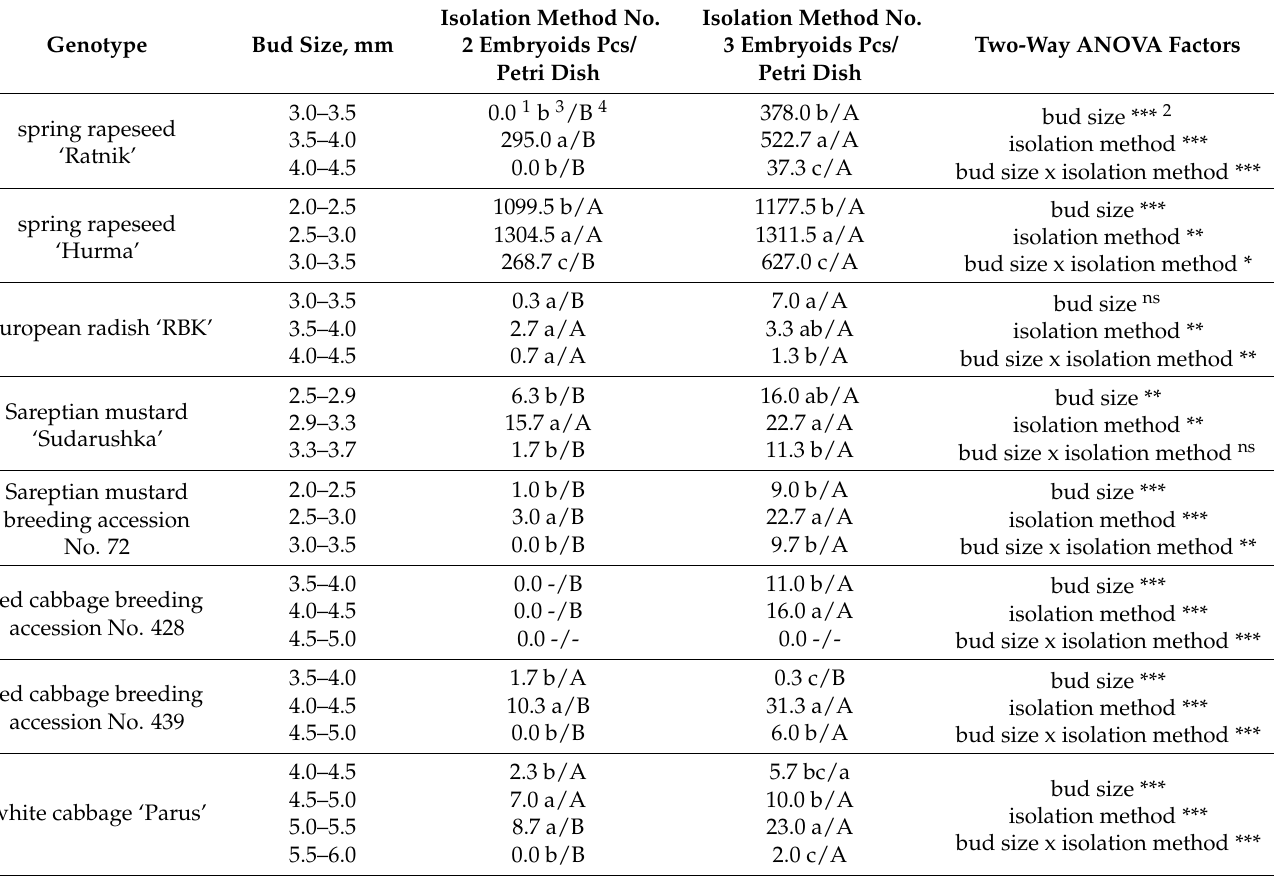
Table 3. Embryoid yield at day 30 of culture depending on the method of isolation method, linear size of buds, and